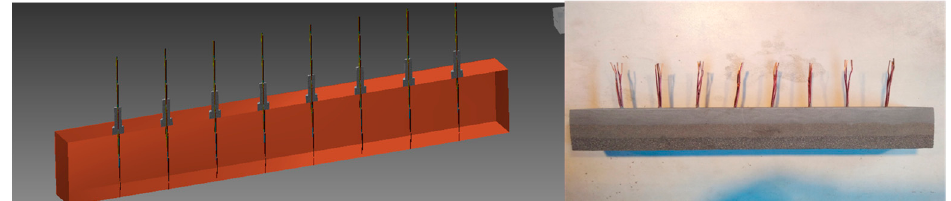
Figure 1. Schematic diagram of the core model (left) and a core sample (right).